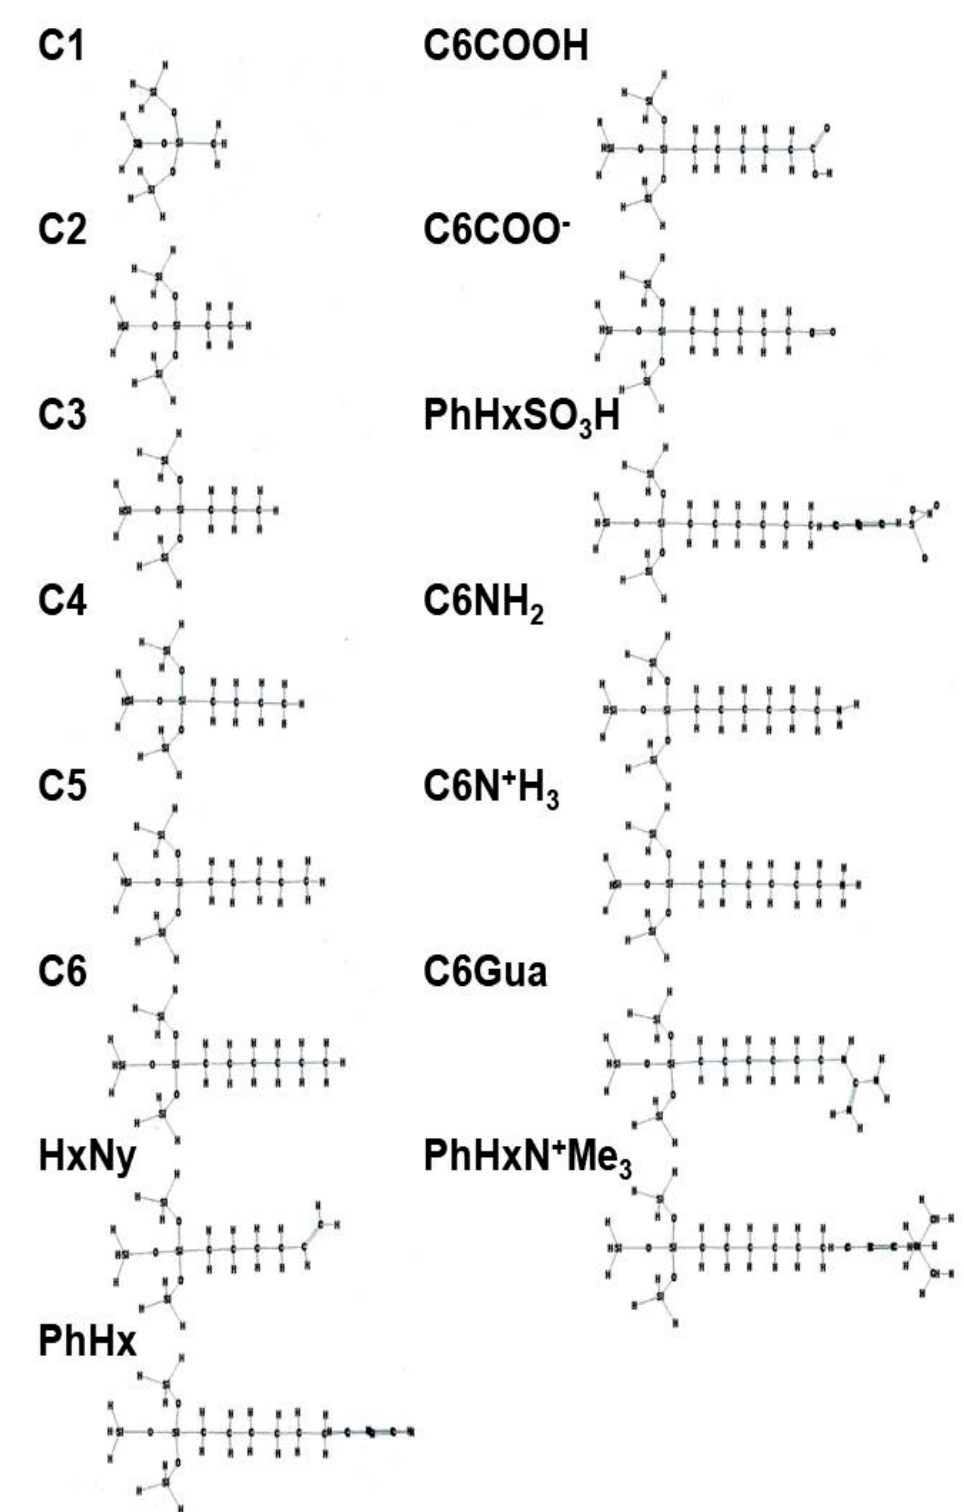
Figure 1. The chemical structure of model compounds, C1–C6: methyl–hexyl bonded; HxNy and PhHx: hexenyl- and phenylhexyl-bonded; C6COOH and C6COO − : molecular and ionized hexyl carboxyl-bonded; C6NH 2 and C6N + H 3 : molecular and ionzed hexylamino-bonded; PhHxSO 3 H and PhHxN + Me 3 ; C6Gua: hexylguadinino-bonded; phenylhexyl-modified sulfonate- and trimethylamino-bonded silicone trioxide, respectively.